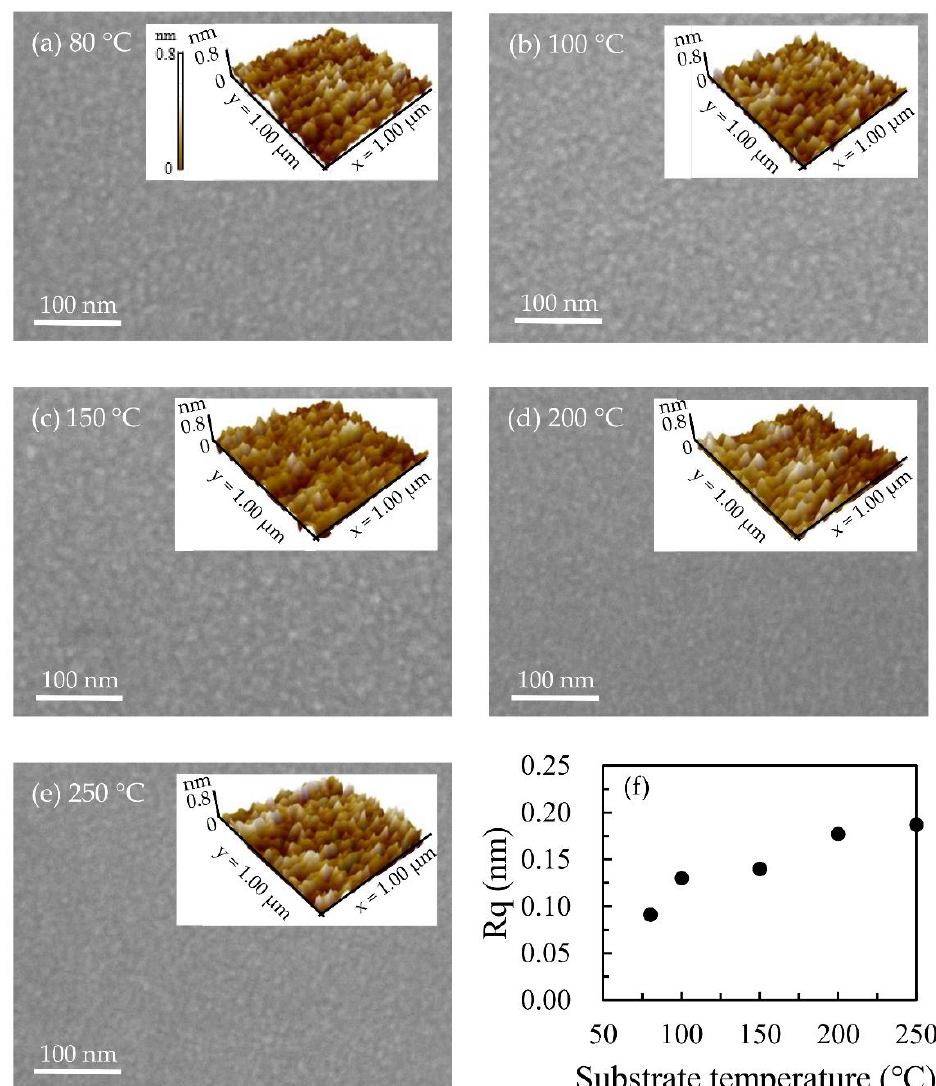
Figure 4. SEM and AFM images for ( a ) 80 °C, ( b ) 100 °C, ( c ) 150 °C, ( d ) 200 °C, and ( e ) 250 °C; ( f ) Rq of the Ga 2 O 3 films as a function of the substrate